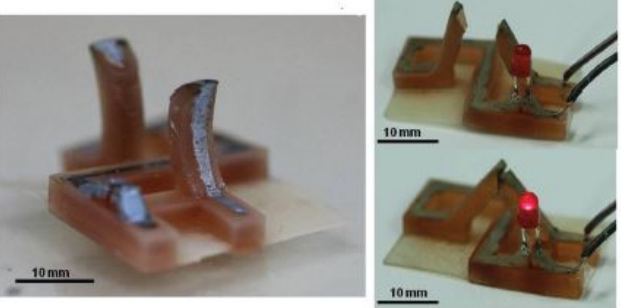
Figure 18. PCL/conductive ink printed parts ( left ) and printed part actuation with a temperature sensor ( right ) [77]. Reproduced with permission from Wiley-VCH.